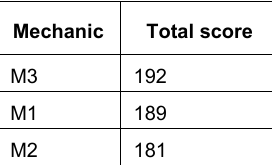
Table 3. Total scores for the mechanics M1, M2 and M3